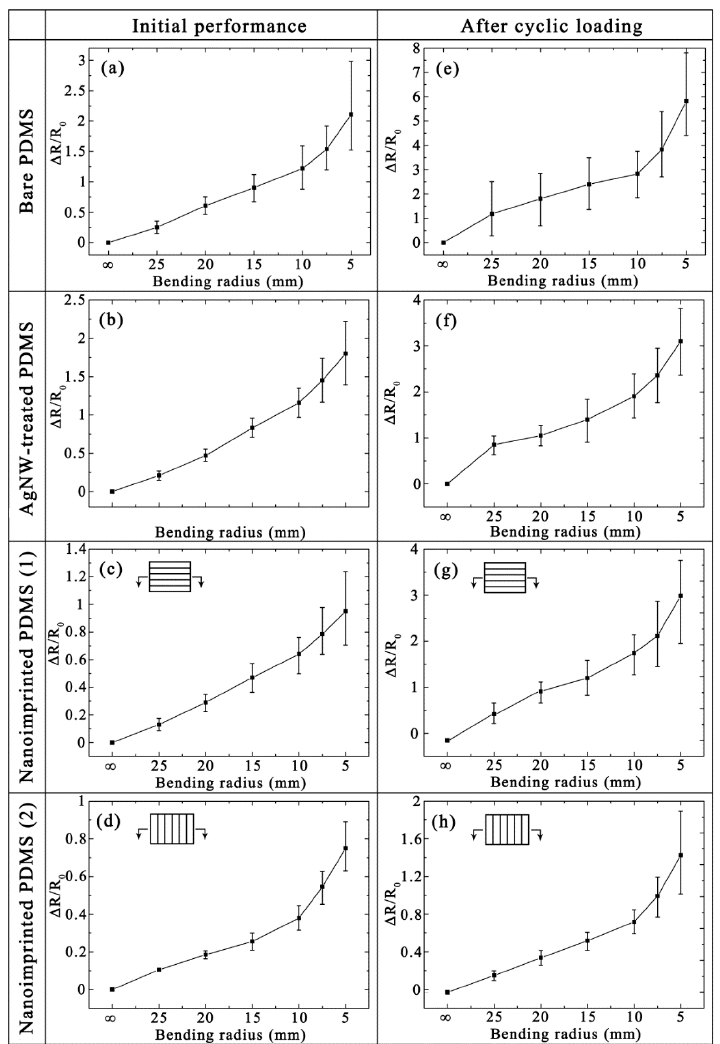
Figure 4. Measured bend-dependent relative Δ R/R 0 of Ag thin film on the bare PDMS, AgNW-treated PDMS and nanoimprinted PDMS substrates under initial state ( a – d ) and after cyclic loading ( e – h ).